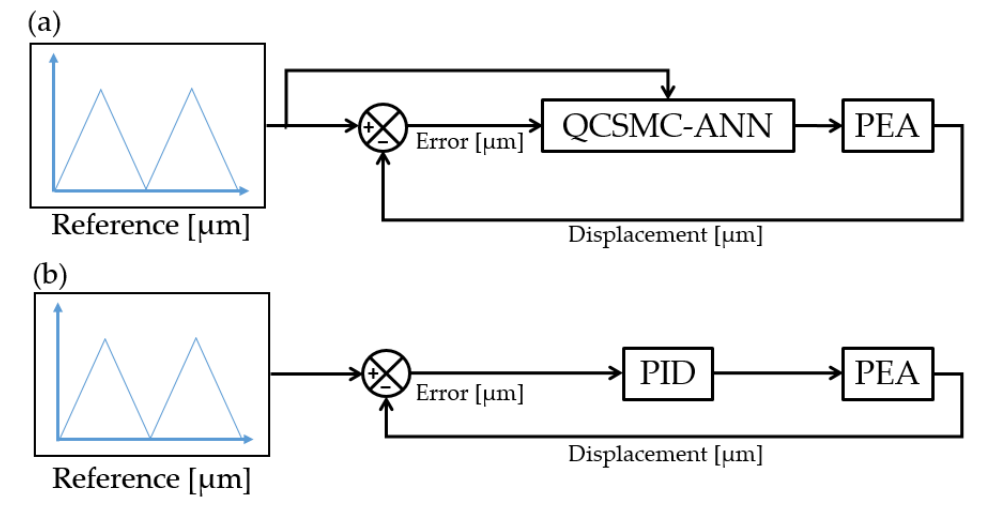
Figure 3. Control schemes used where ( a ) is the proposed QCSMC-ANN and ( b ) is the contrasted